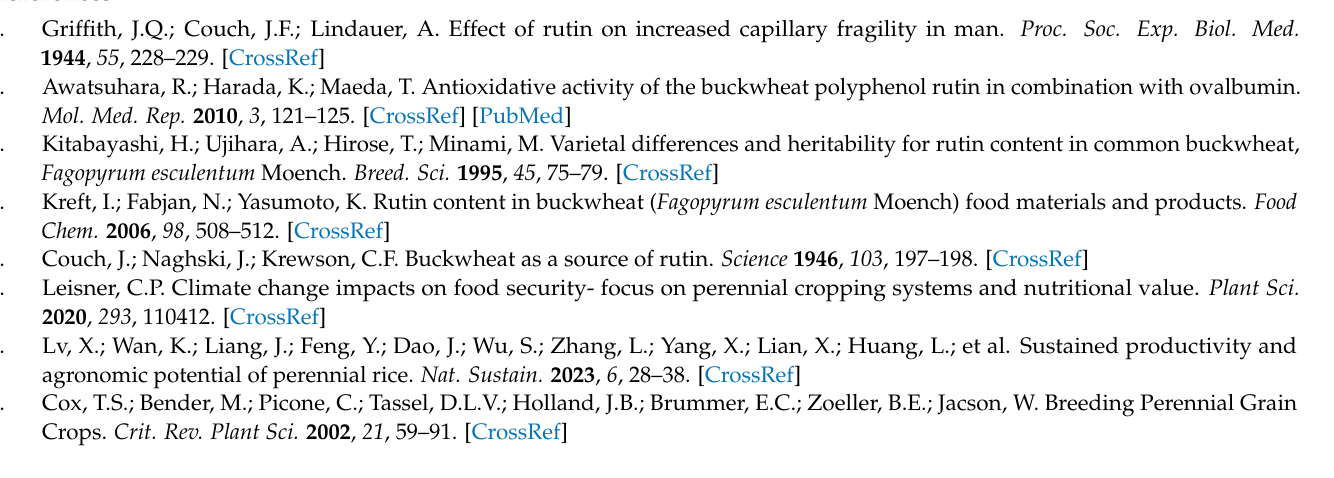
Figure S2: Tissue distribution of rutin and rutinosidase activity in FC seed; Figure S3: